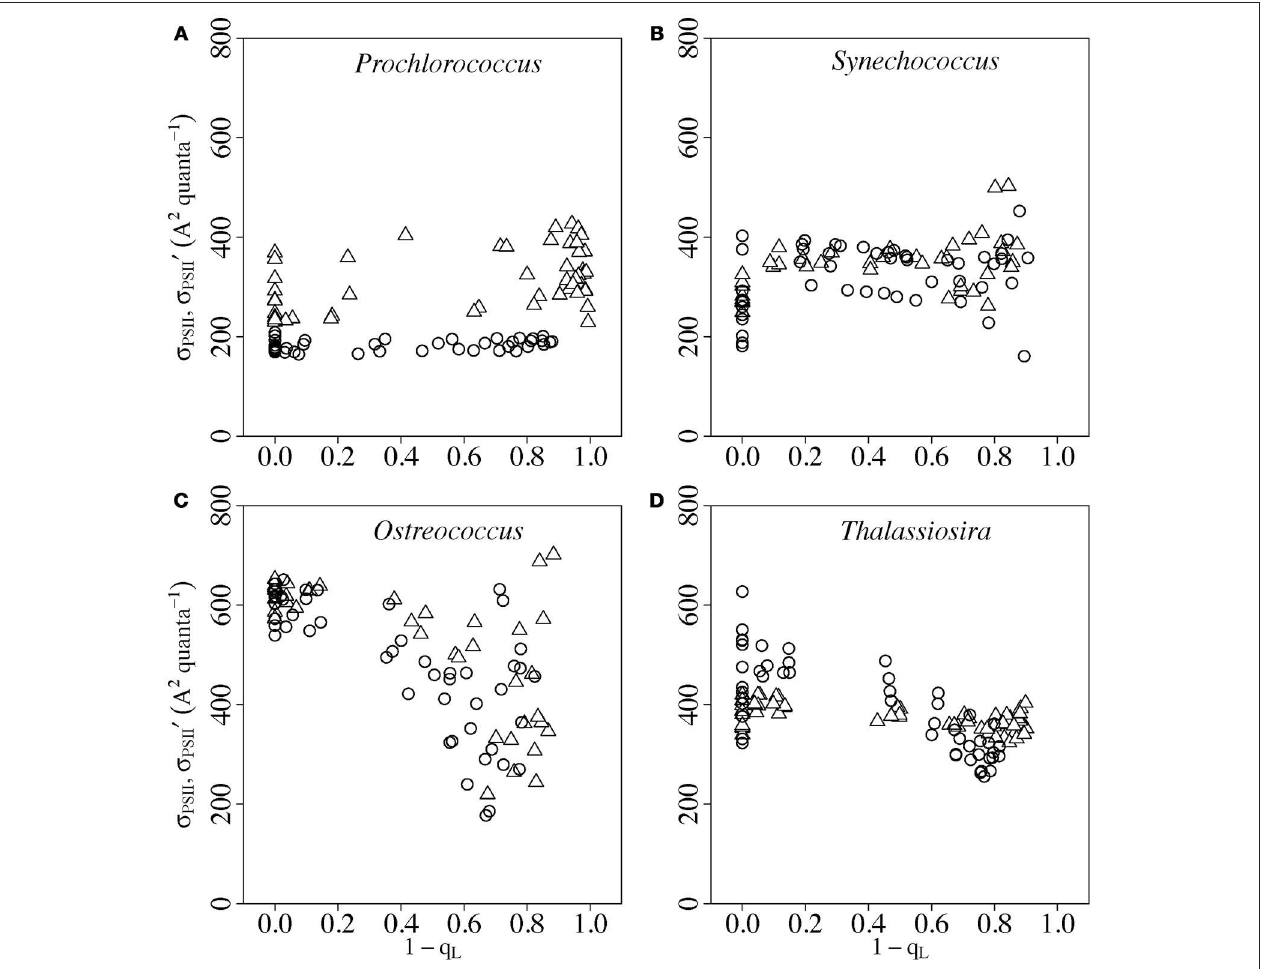
FIGURE 2 | Response of σ PSII ′ to progressive closure of Photosystem II (1-q L ) in Prochlorococcus (A) , Synechococcus (B) , Ostreococcus (C) or Thalassiosira (D) from growth-limiting (open triangles) or growth saturating light (open circles). Photosystem II closure was driven by increasing actinic light ( Figure 1A ). Paired determinations from 4 to 8 replicate cultures plotted